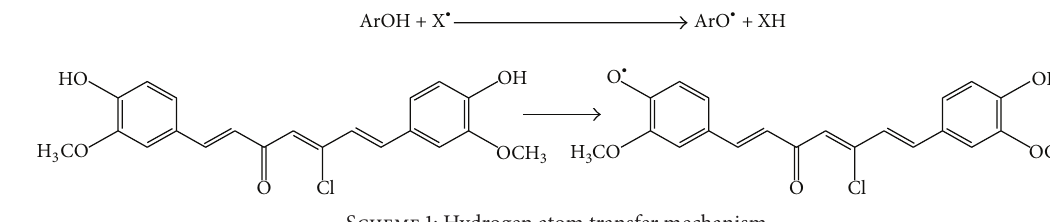
Scheme 1: Hydrogen atom transfer mechanism.